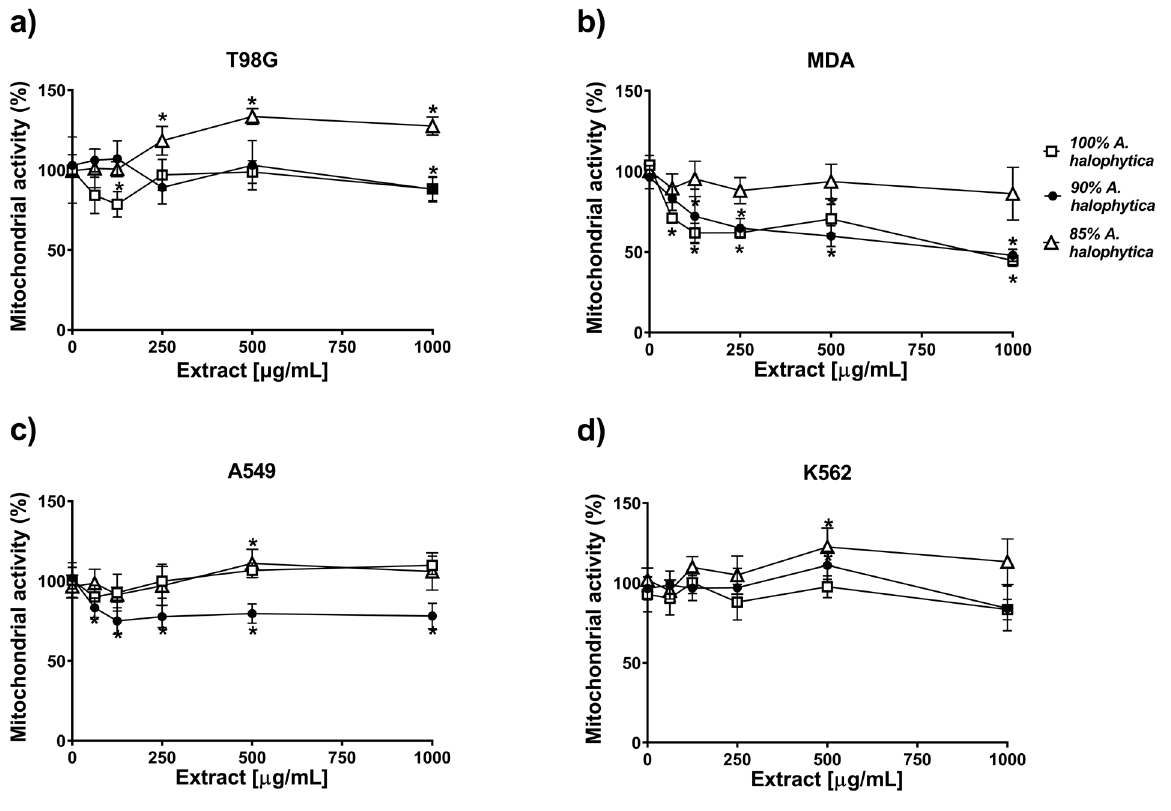
Figure 1. In vitro evaluation of the cytotoxic activity of Aphanothece halophytica extracts. Viability of human T98G(a), MDA231(b), A549(c), K562(d) cells cultured with crude cyanobacterial extracts after 72 hours by the MTT method. Representative result of 3 independent experiments performed in eight replicates, being the mean ± standard deviation. Two-way ANOVA with Dunnett‘s post-test relative to control; * P <0.05.